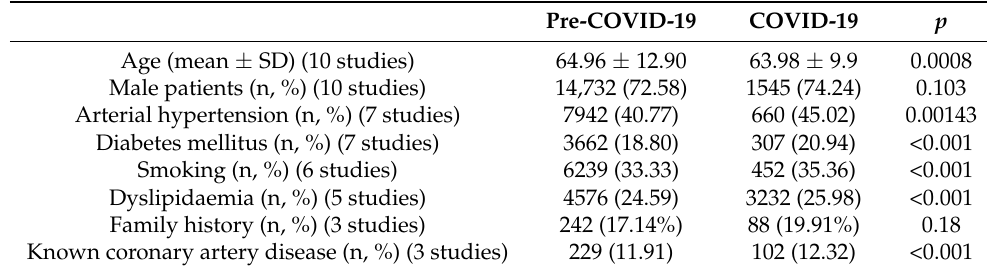
Table 3. Patient baseline